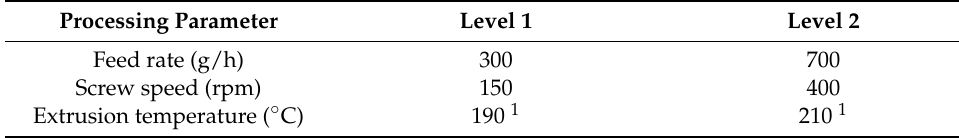
Figure 1. Screw profile that was selected for the material compounding. Table 1. Selected controllable processing parameters and levels.